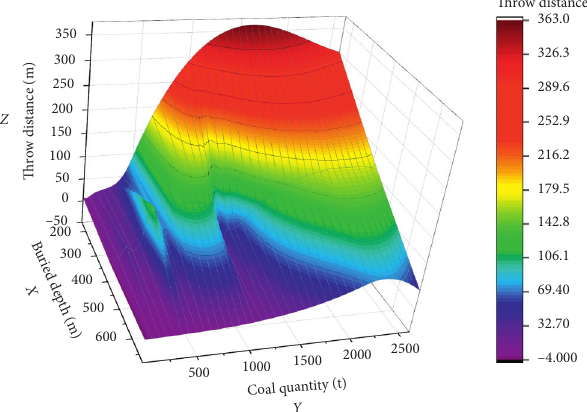
Figure 6: 3D colormap surface of buried depth, coal quantity, and throw distance ( XYZ gridding).